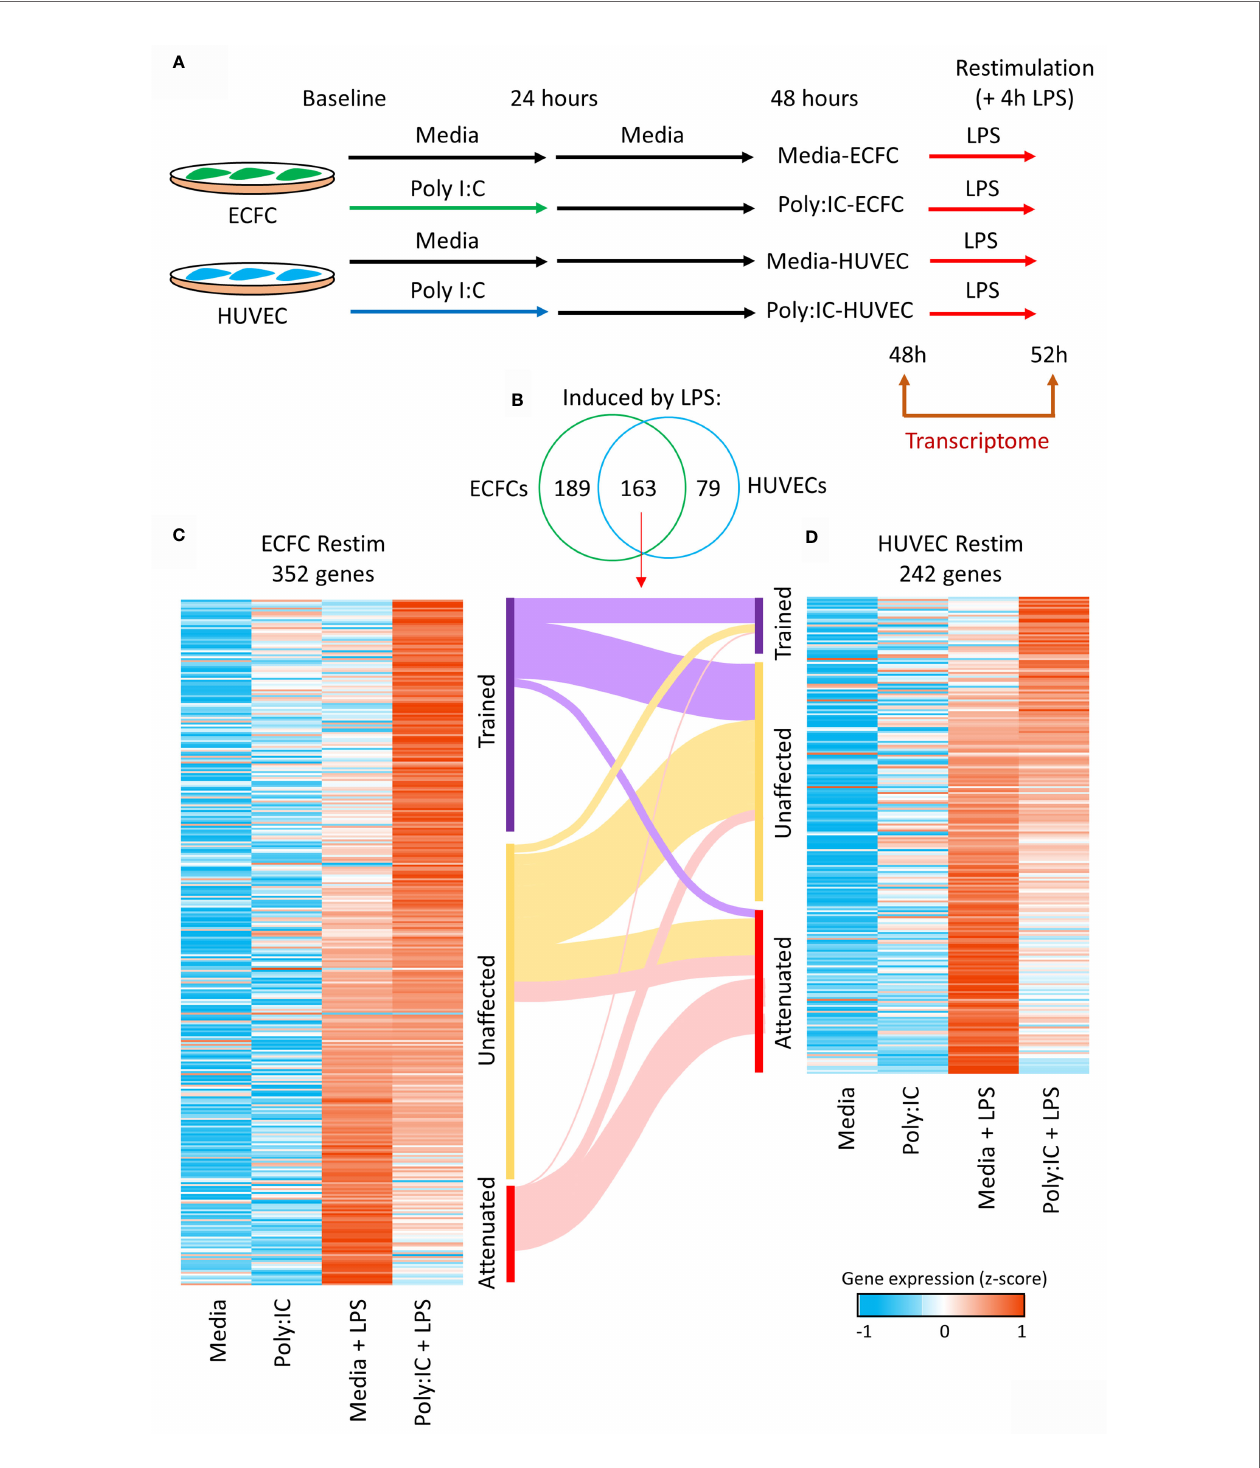
FIGURE 4 | Trained immunity in ECFCs and HUVECs. (A) Ex vivo model to test Poly(I:C) induced trained immunity in fetal endothelial cells. Cells were exposed to Poly(I:C) for 24h, followed by 24h rest, and re-stimulation with LPS, an unrelated microbial compound. RNA-seq data was generated at 48h and 52h (4h after LPS exposure). (B) A total of 352 and 242 genes are induced by LPS in ECFCs and HUVECs, respectively, of which 163 are induced in both. (C, D) Heatmap of the LPS inducible genes in ECFCs and HUVECs, ranked from trained to tolerized by Poly(I:C). A Sankey plot shows the overlap between trained, equal and tolerized genes in ECFCs and